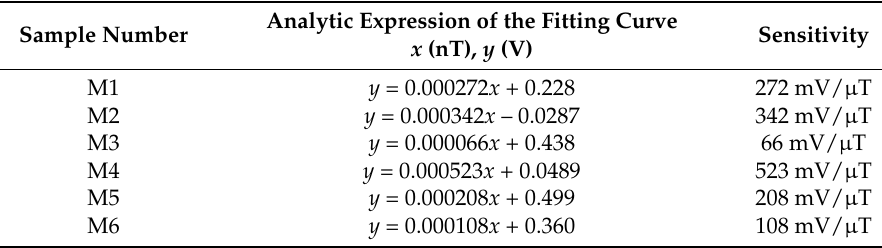
Figure 7. Output properties for different magnetometer models. Reproduced with permission from [29], published by IEEE, 2013. Table 2. Sensitivity of different device types.